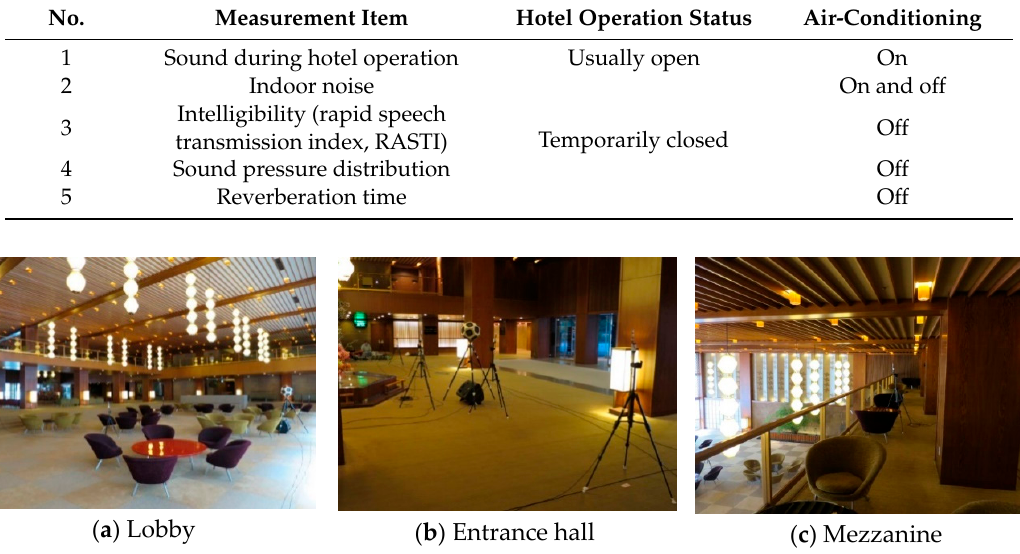
Table 1. Measurement items and operational status.